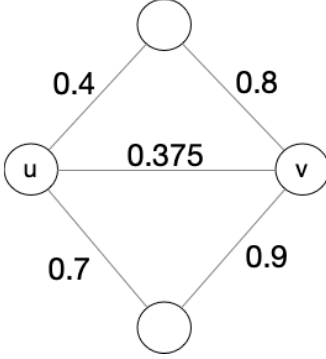
Figure 4. The recomputed weight graph g’.